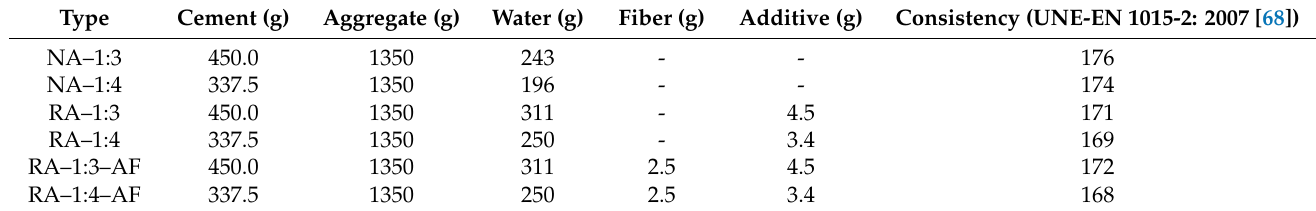
Table 5. Dosages used for the elaboration of mortars.